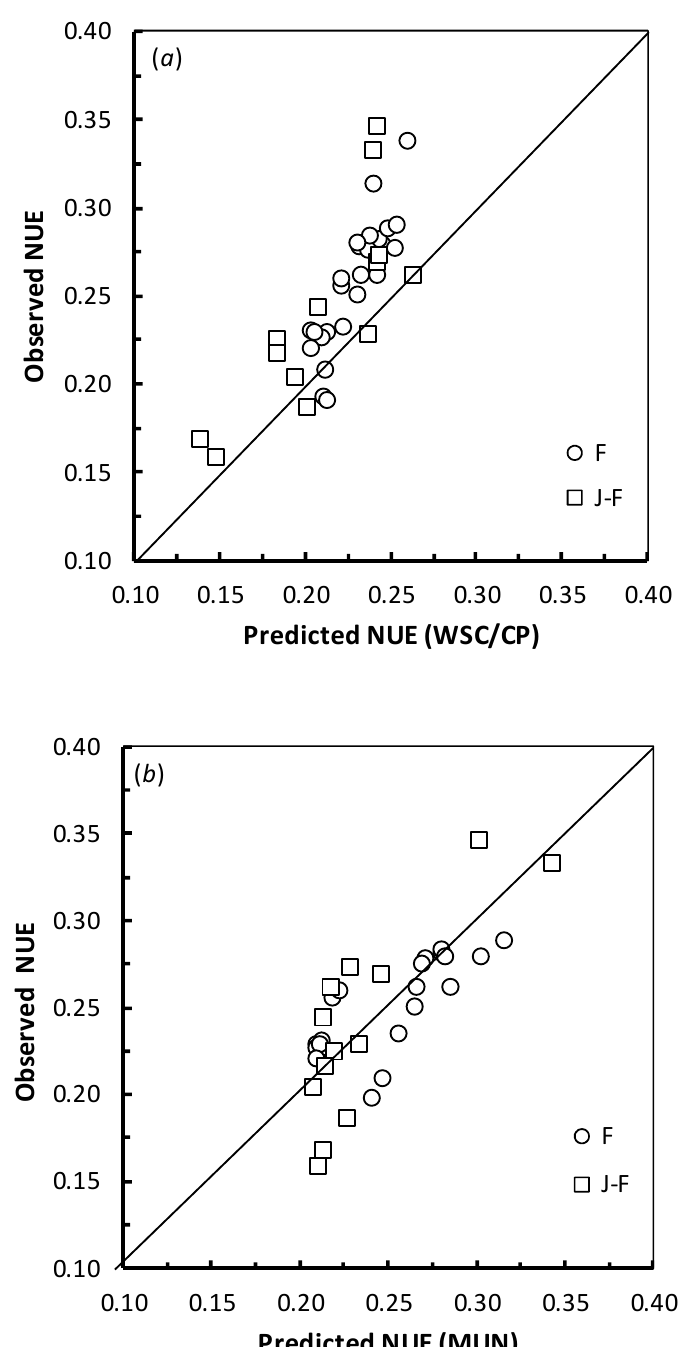
Figure 4. Correspondence of observed NUE values with those predicted using models based on ( a ) WSC/CP (Models 7 and 8; Table 6) and ( b ) MUN (Model 10; Table 6) for groups of Friesian (N = 27) and Jersey × Friesian (N = 13) cows not used in model development. The straight line indicates one-to-one correspondence between observed and predicted values.